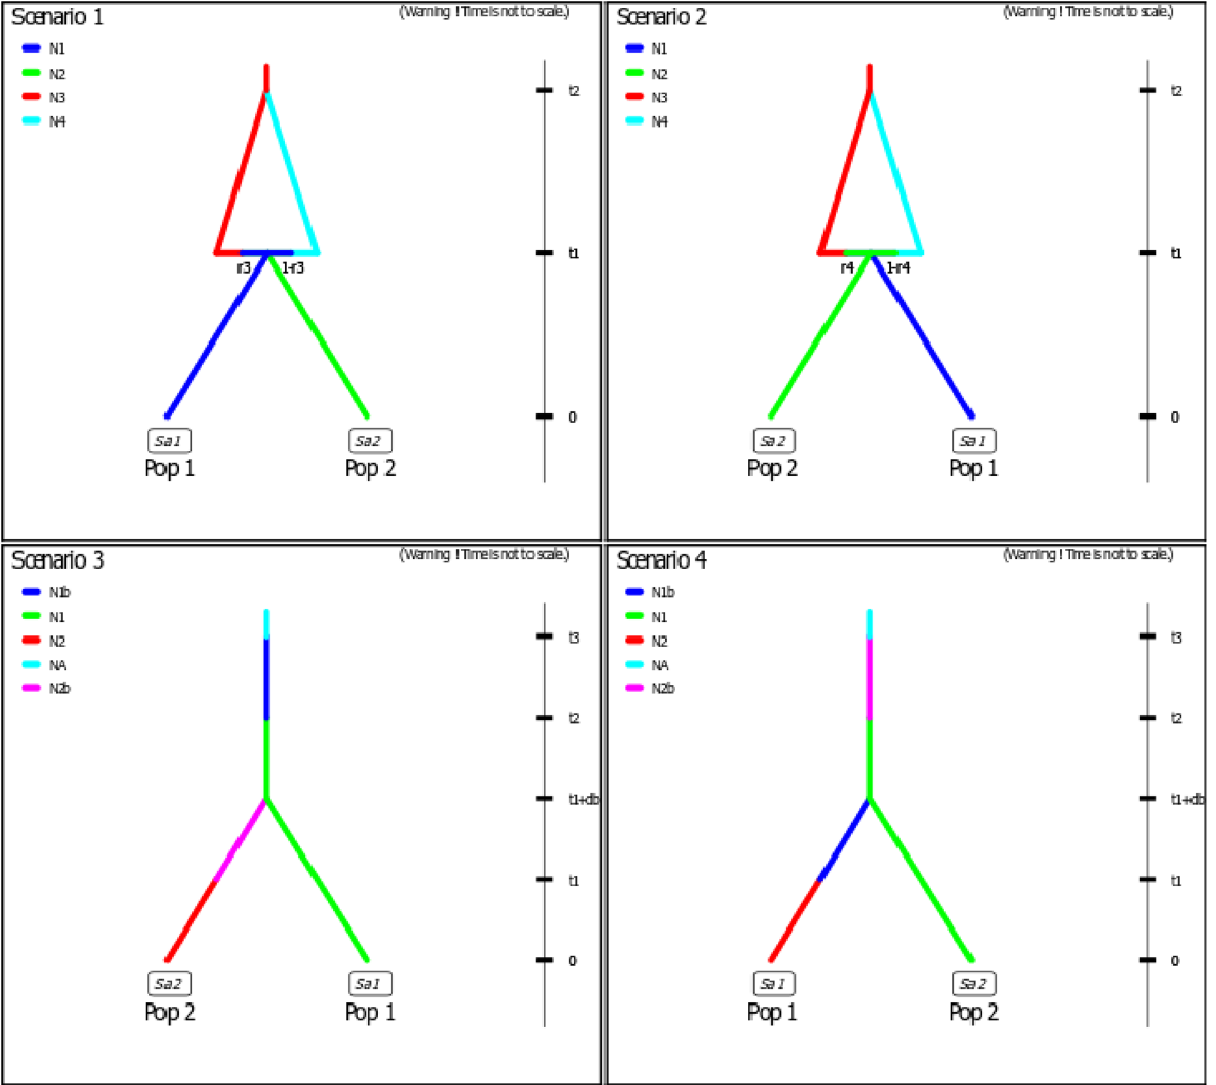
Figure 4. Evolutionary scenarios tested using DIYABC. Scenario 1 assumes that the colonization of both Biomes occurred from a single ancestral population (possible glacial refuge), populations established in Grassland and Savanna diverge and later an admixture event occurs with south- north direction. Scenario 2 proposes a similar demographic hypothesis to Scenario 1, except that the colonization that resulted in the admixture event occurred from north (Savanna) to south (Grassland), Scenarios 3 assumes that colonization occurred from a single ancestral population, reaching the Grassland region first and from there continuing north, reaching Savanna. Scenarios 4 represent the hypothesis of a colonization event with north- south (Savanna- Grassland) direction, from a single ancestral population and the subsequent divergence of the populations established in both Biomes. Changes in effective population size (Ne) are represented as differently shaded lines. Pop1 is referred to Grassland and Pop2 to